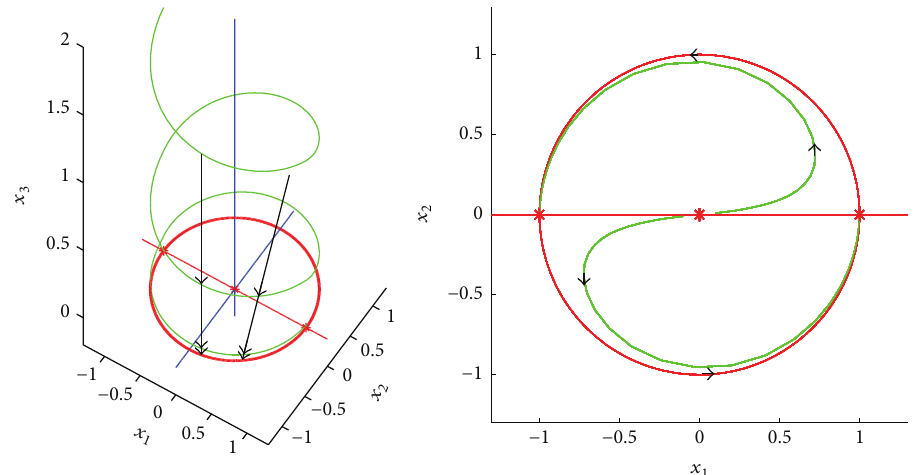
Figure 1: Illustration of the geometry and limit sets in Thieme’s [4] example